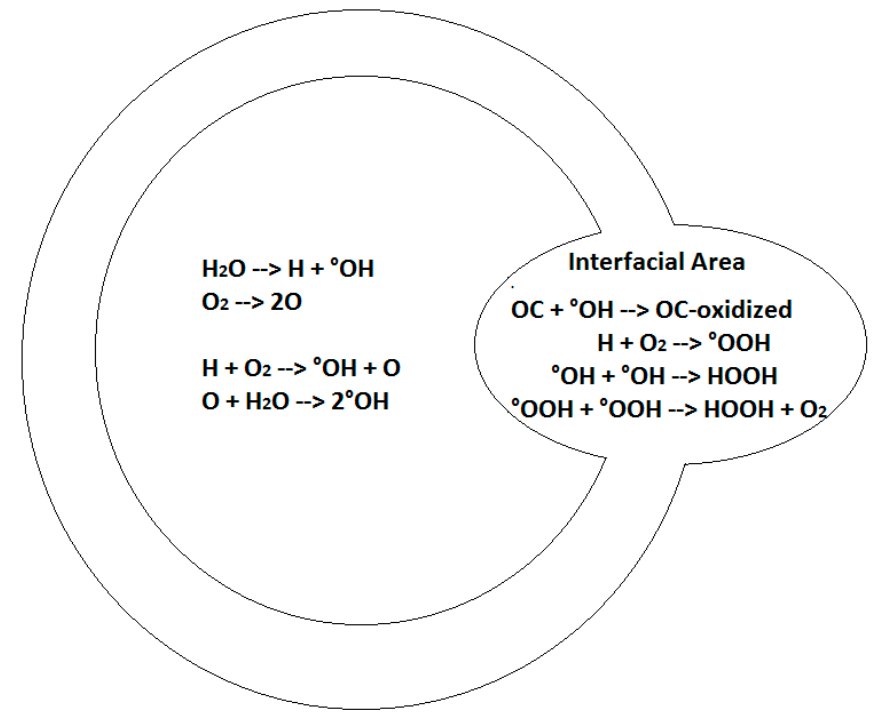
Figure 6. Scheme of the main reactions occurring in and at the interface of the bubble that account for the hydrophilic organic compounds’ (OC) oxidation.